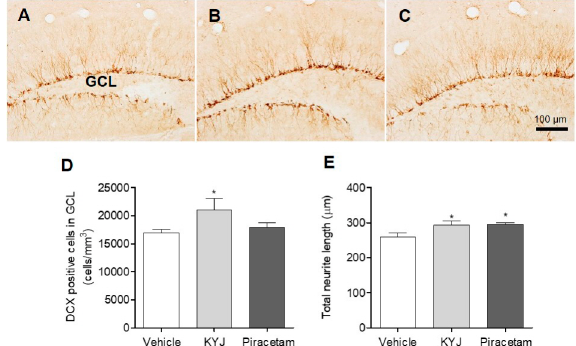
Figure 6. KYJ promoted hippocampal cell differentiation and neurite extension in mice. ( A – C ) Representative images are shown: ( A ) vehicle-treated group, ( B ) KYJ 200 mg/kg/day p.o. group, ( C ) piracetam 200 mg/kg/day i.p. group. ( D ) The number of DCX-positive cells in the GCL region was quantified via stereological counting. ( E ) The total neurite length was the sum of DCX-positive cell’s neurite length. * p < 0.05 vs. the vehicle-treated